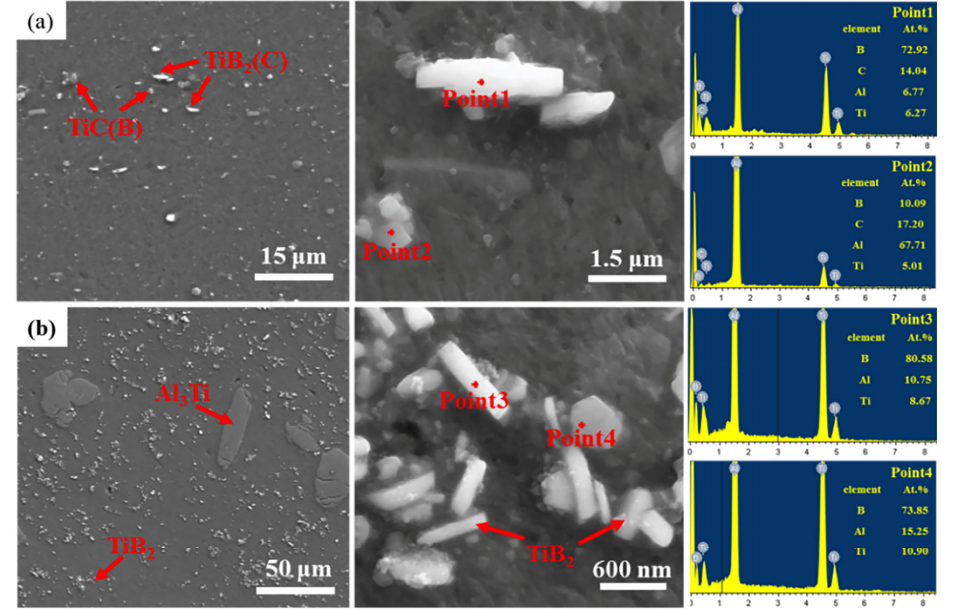
Materials 2023 , 16 , x FOR PEER REVIEW Figure 4. SEM analysis and EDS point analysis: ( a ) Al-5Ti-0.25C-0.25B; ( b ) Al-5Ti-1B. 3.2. Analysis of Microstructure and Mechanical Properties of As-Cast Al-9.5Si-1.5Cu-0.8Mn- 0.6Mg Alloy